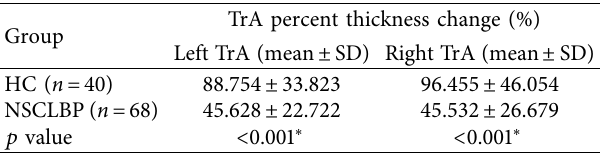
Table 3: TrA percent thickness change contrasting the two